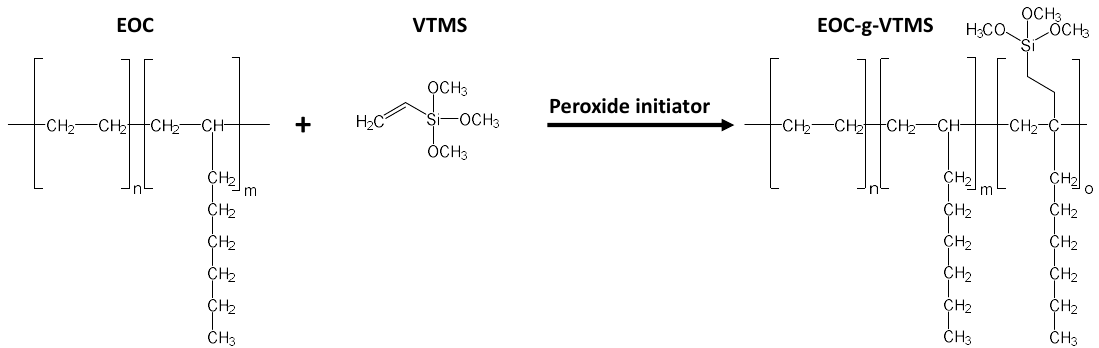
Figure 1. Peroxide initiated grafting reaction of vinyltrimethoxysilane (VTMS) onto ethylene-octene copolymer (EOC).